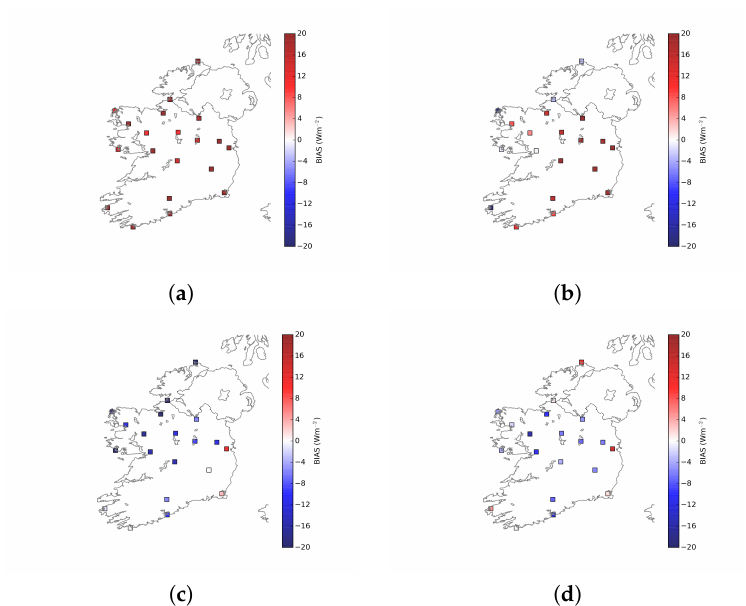
Figure 4. Daily mean GHI, averaged over the 28 GHI stations in the Danish network. The observed averages are shown with the red curve; the averages from the HARMONIE-AROME NEA weather model are shown with the green curve; and the model bias is shown with the blue curve. The cyan curve is the Bézier smoothed biases.